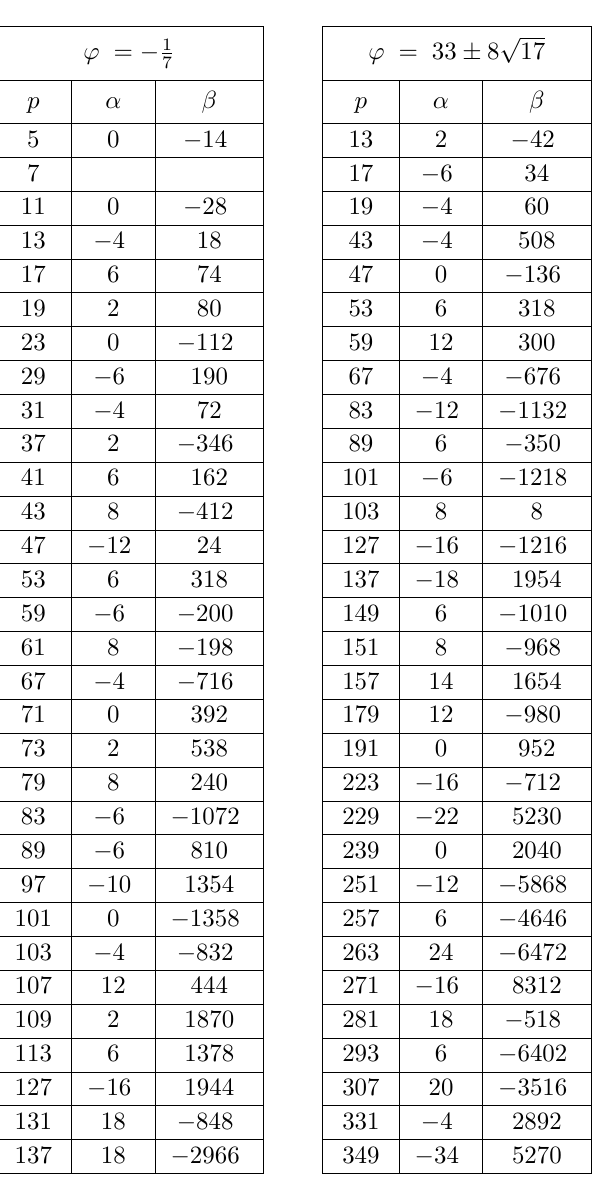
p and ’ = 33 (cid:6) 8 17. 7